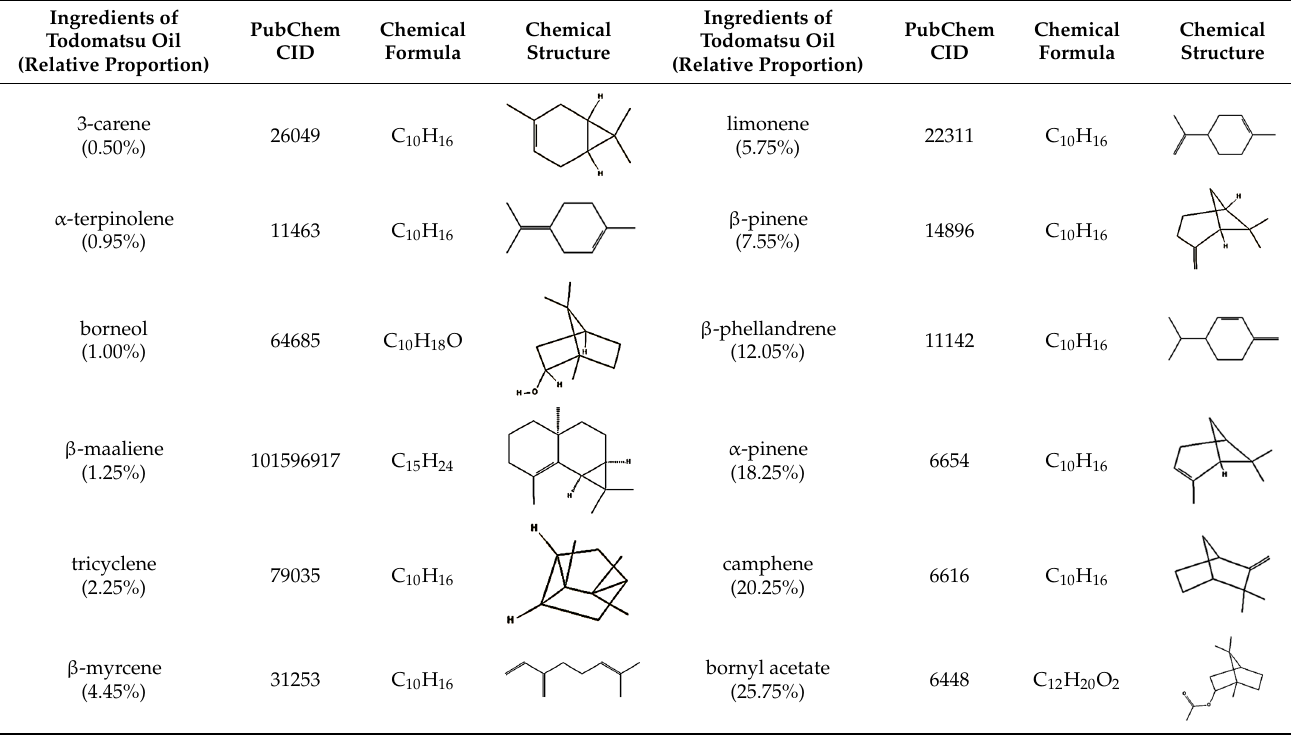
Table 1. List of the ingredients of todomatsu oil and their chemical structures.